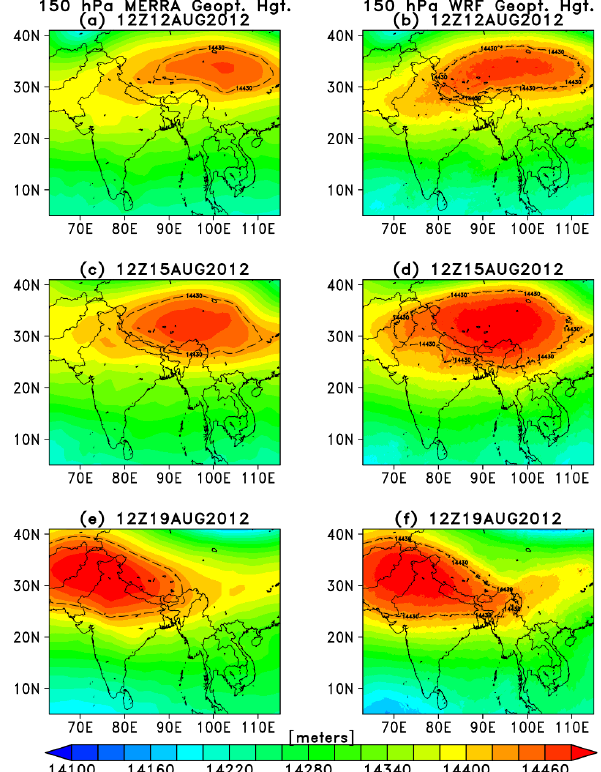
Fig. 3. MERRA (left column) and WRF (right column) geopotential height (m) at 150hPa for 12:00UTC 12 August 2012 ( a and b ), 12:00UTC 15 August ( c and d ), and 12:00UTC 19 August ( e and f ). The dashed contour represents our definition of the ULAC at this pressure level